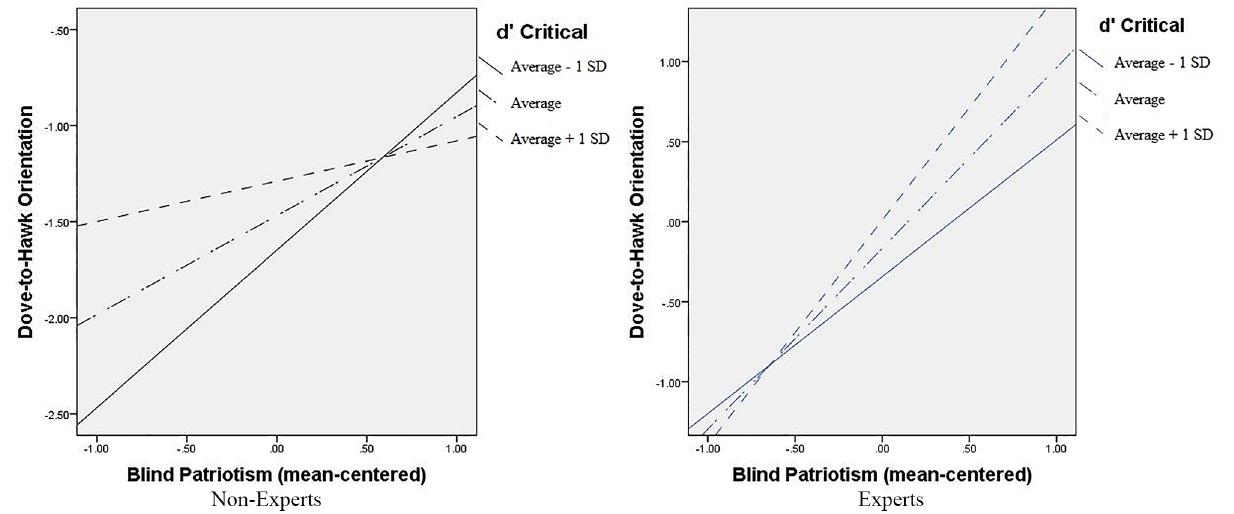
Figure 3. Comparing non-experts and experts on relationships between blind patriotism, knowledge, and policy